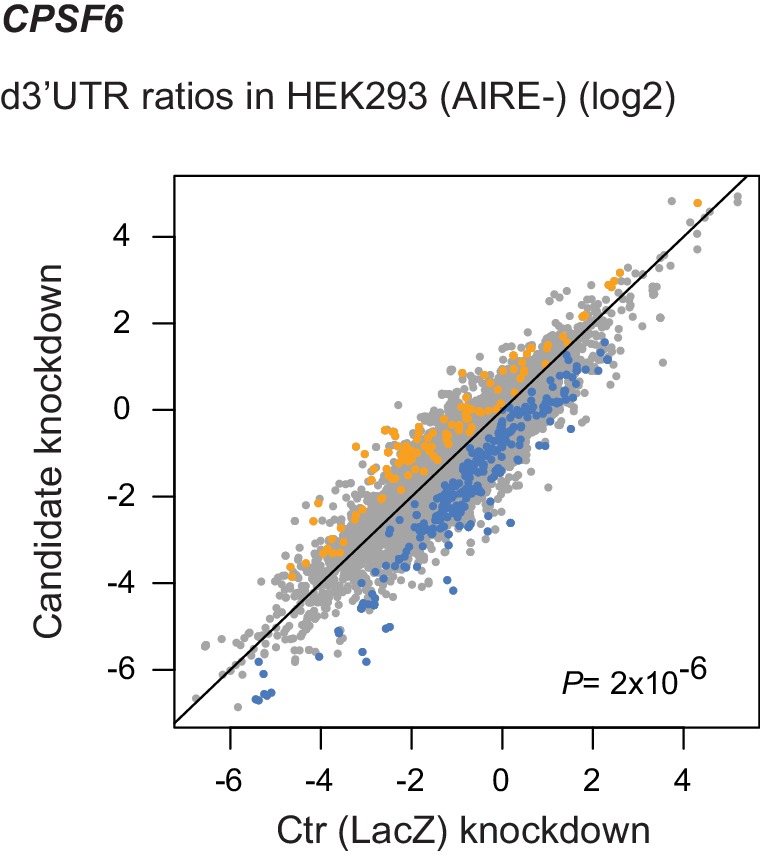
CPSF6 promotes 3’UTR lengthening.Individual probe-level analysis of microarray data in HEK293 cells infected by a lentivirus targeting CPSF6. Genes whose d3’UTR ratios show significant increase or decrease in the CPSF6 vs. Ctr (LacZ) knockdown sample are represented in orange or blue respectively, otherwise in gray.